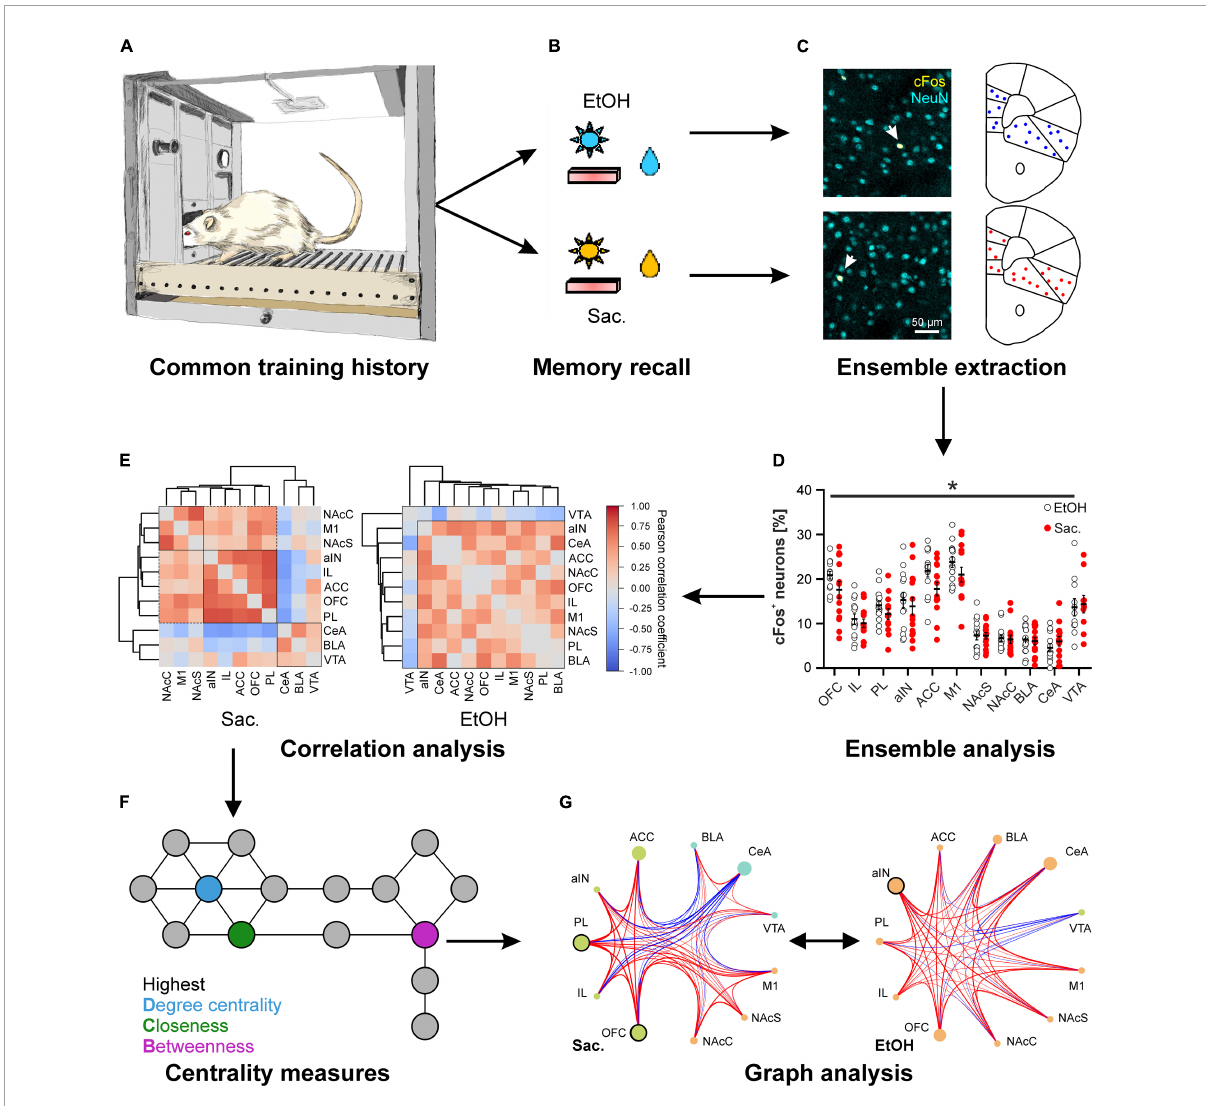
FIGURE1 Distinct cue-reward memories are encoded by specific meta-ensembles consisting of co-active neuronal ensembles spread across multiple brain regions. Rats trained on a concurrent 2-reward operant self-administration paradigm establish memories for both rewards (A) that are retrieved under reinstatement conditions, meaning that previously learned reward-specific cues are presented but seeking behavior is not rewarded (B) . (C,D) Postmortem cFos expression analysis allows the analysis of neuronal ensembles within distinct brain areas. (C) Representative images of immuno double-labeling of cFos and the pan-neuronal marker NeuN, to determine the fraction of activated neurons, in the central amygdala after reinstatement for alcohol (top) and saccharin (bottom). (D) Quantification of the fraction of cFos labeled, activated neurons in 10 different reward-related brain regions after reinstatement for either alcohol (EtOH, white circles) or saccharin (Sac., red circles) (Data is presented as mean ± s.e.m., * p < 0.05, two-way ANOVA, main effect of group). (E–G) Reward-specific properties of brain activity are only evident after analysis of co-activity across brain regions (E) and subsequent graph theory-based analyses (G) such as analyses of centrality measures (F) . (E) Hierarchical clustering of brain regions according to the Pearson correlation coefficients derived from the fraction of cFos labeled neurons after reinstatement for saccharin (Sac., left) or alcohol (EtOH, right). (F) Scheme illustrating three commonly used centrality measures to analyze networks. The degree centrality is defined as the number of nodes directly connected to the node of interest. The closeness and betweenness are measures for the distance from the node of interest to all other nodes and the number of shortest connections between all other nodes that run via the node of interest, respectively. That means, nodes with a high degree centrality have many direct neighbors while those with a high closeness are at short distance to many other nodes. A high betweenness on the other hand indicates that a lot of (short) connections between other nodes, and thus information, run via the node of interest. (G) Example for the analysis of networks derived from the fractions of cFos labeled neurons after reinstatement for saccharin (Sac., left) and alcohol (EtOH, right) showing the recruited meta-ensembles. The size of the circles represents the importance of the brain region in information flow derived from centrality analysis and the strength and color of the connecting lines represents properties of network edges based on the Pearson correlation coefficients (thicker lines = stronger correlation, red: positive correlation, blue: negative correlation). Brain region labels: ACC, anterior cingulate cortex; aIN, anterior insular cortex; BLA, basolateral amygdala; CeA, central amygdala; IL, infralimbic cortex; M1, primary motor cortex; NAcC, nucleus accumbens core; NAcS, nucleus accumbens shell; OFC, orbitofrontal cortex; PL, prelimbic cortex; VTA, ventral tegmental area. [cFos staining in panel (C) as well as panels (D–G) reproduced from Wandres et al.